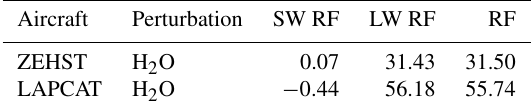
Table A1. Short- and longwave contributions to radiative forcing in mWm − 2 for EMAC, including upper tropospheric perturbation of water vapor, ozone, and methane, and the related error potential of approximately 51% to 63% due to the integration of tropospheric perturbations.